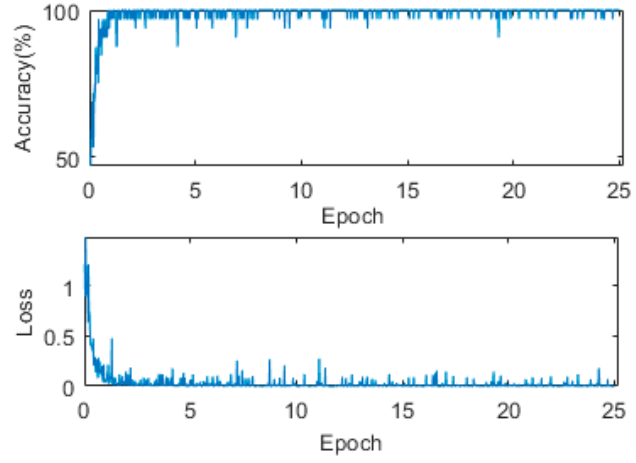
Figure 6. Loss and accuracy in classification network training of Secchi